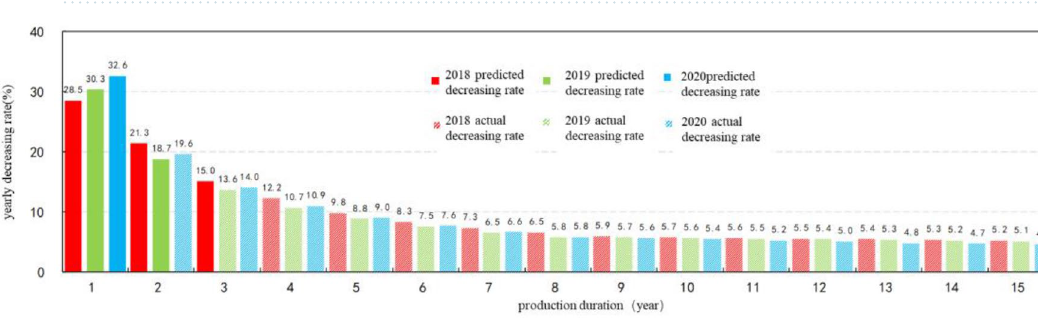
Figure 11. Fitting curve of yearly production drop of horizontal wells in Qingcheng area.